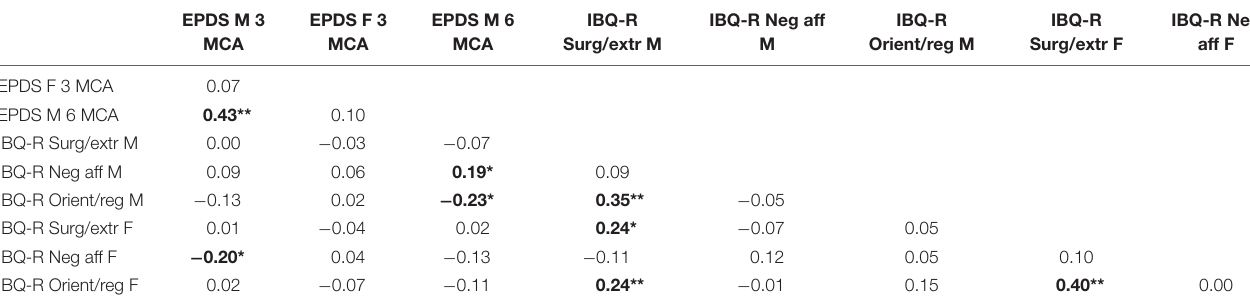
TABLE 3 | Correlations ( τ b ) between mothers’ and fathers’ EPDS scores at 3 and 6 months corrected age and IBQ-R scores at 3 months corrected age.